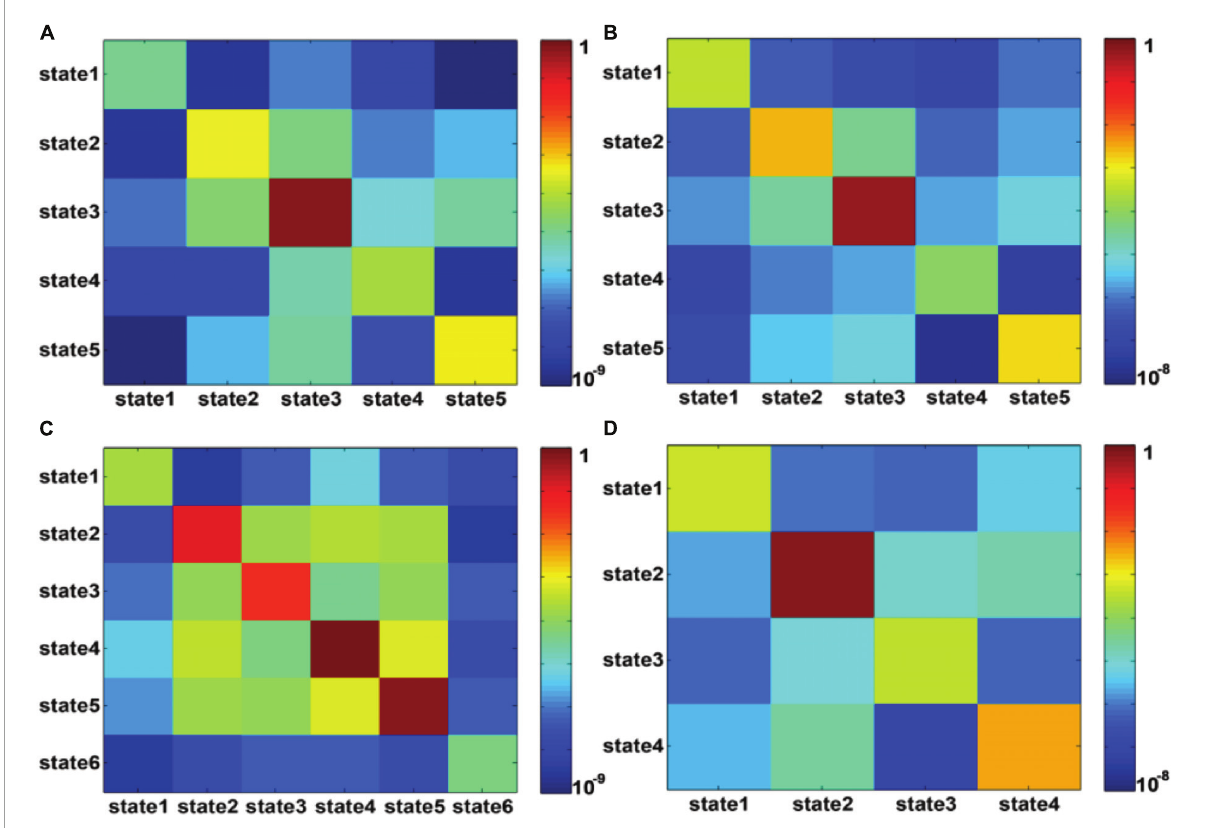
FIGURE7 (A,B) represent the transition probability among DFC states for presailors and backsailors, where the DFC states obtained from the DFC matrices of all seafarers before and after sailing. (C,D) represent the transition probability among DFC states for presailors and backsailors, respectively, where the DFC states obtained from the DFC matrices of seafarers before and after sailing, respectively. Note that transition probability is color-mapped on a log-scale.